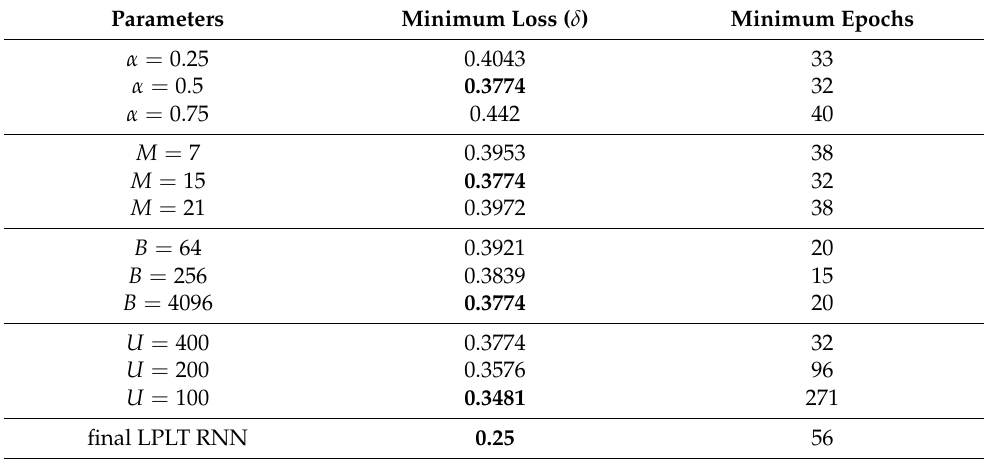
Table 2. RNN parameter optimization. Minimum binary cross-entropy loss of the validation data set for the LPLT SFN.